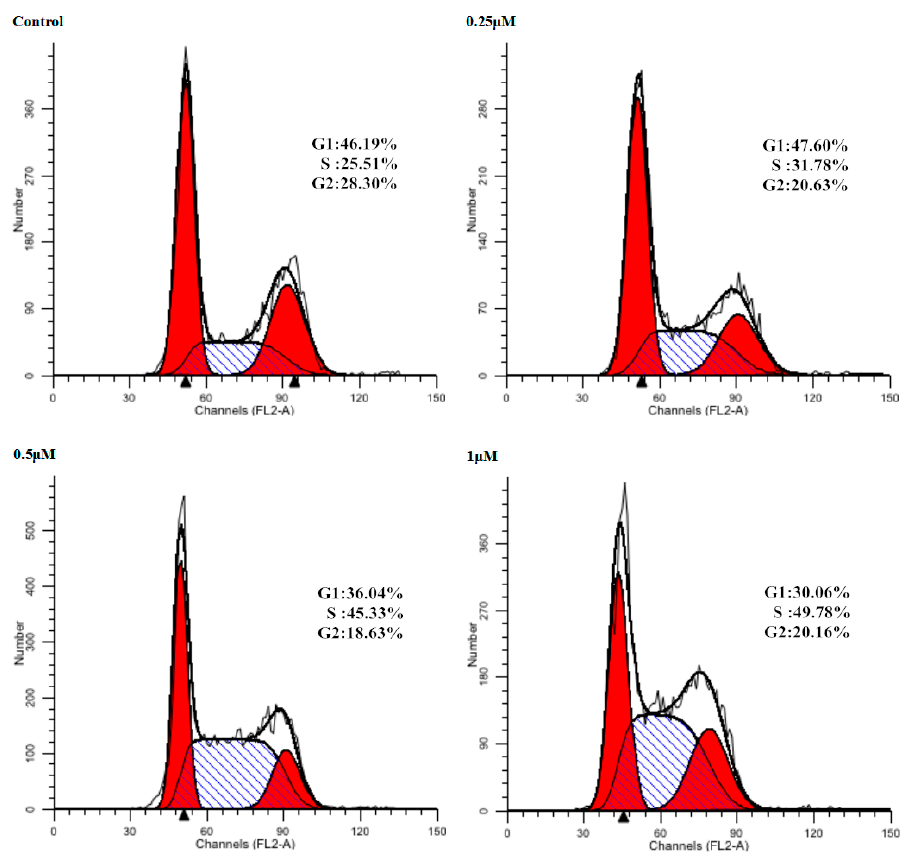
Figure 2. Influence of Bel-7402 cell cycle by 9f . Left red part: cells in G 1 phase; Right red part: cells in G 2 phase; Oblique line part: cells in S phase; White part: total cells.